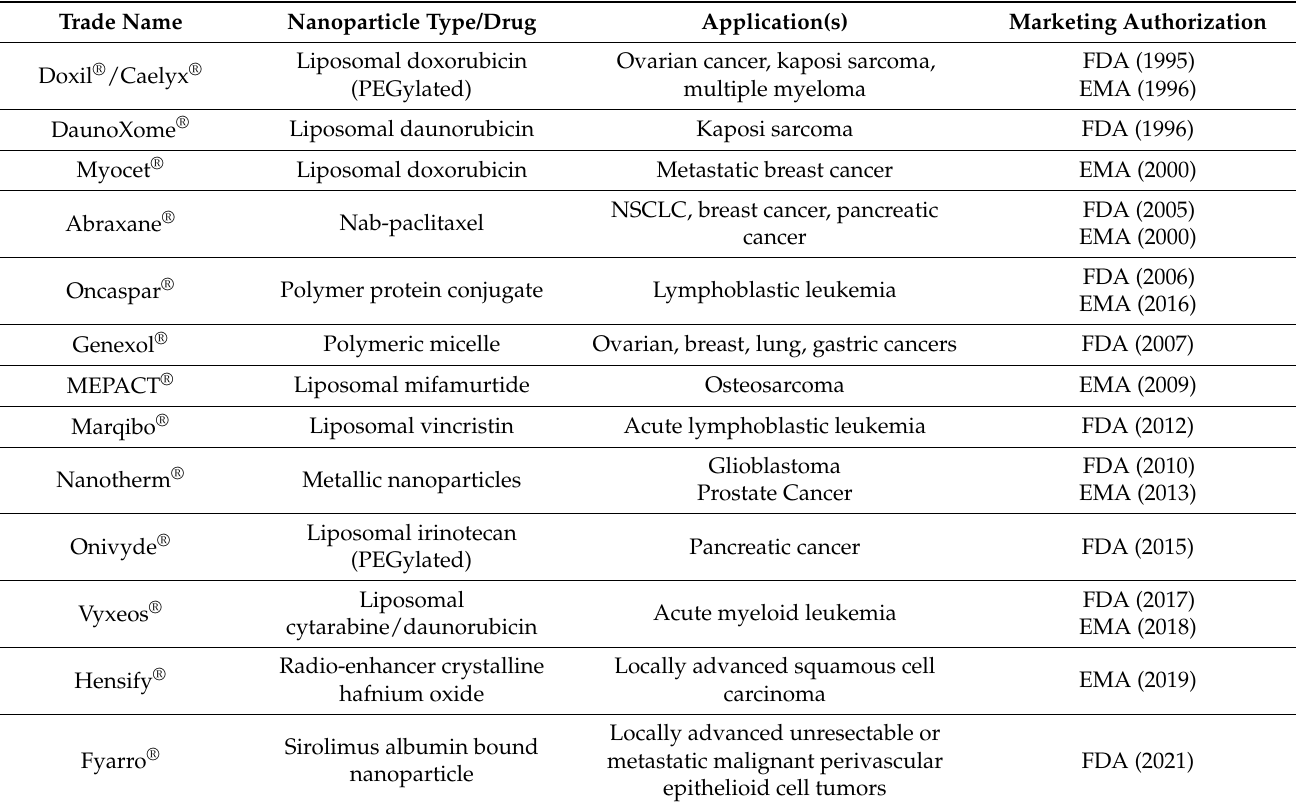
Table 1. Anticancer nanomedicine currently approved by the FDA and/or EMA. Adapted from Anselmo et al. [5]. Of note: ADCs will be developed in Table